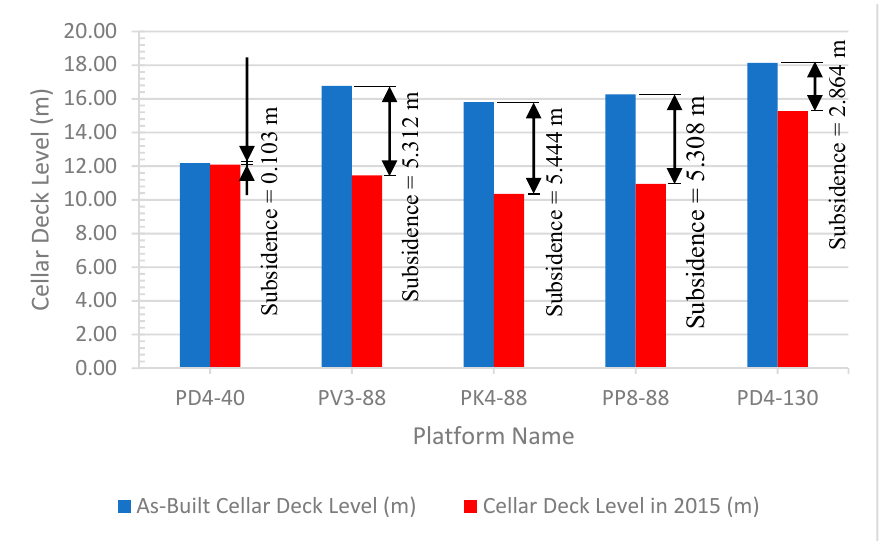
Figure 6. Platform subsidence.